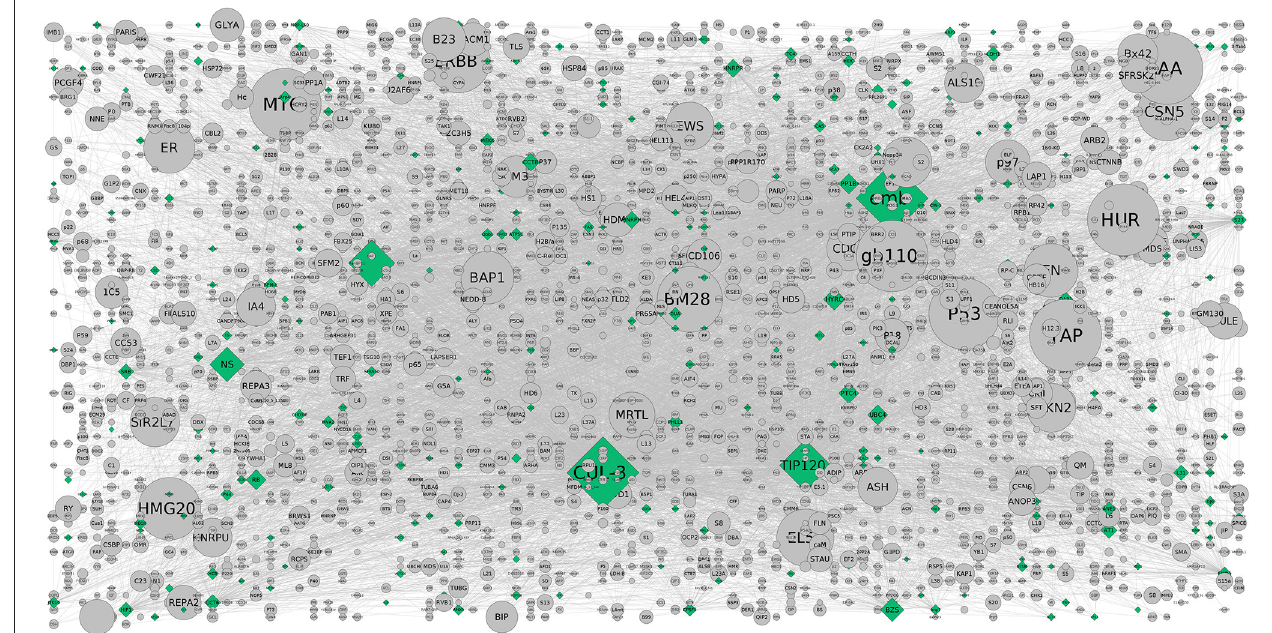
FIGURE 3 | The CHAT generated grid network with DEGs shown in (contextual) green and (non-contextual) gray colors. The contextual nodes are in pyramid shape while the non-contextual nodes are circled with the size indicating the extent of contextuality. For example, CUL-3 and TIP120 are contextually important genes relevant to the pathways and are contextually important with a good clustering co-efficient and P -value ( < 0.05) ( Supplementary Table 3b